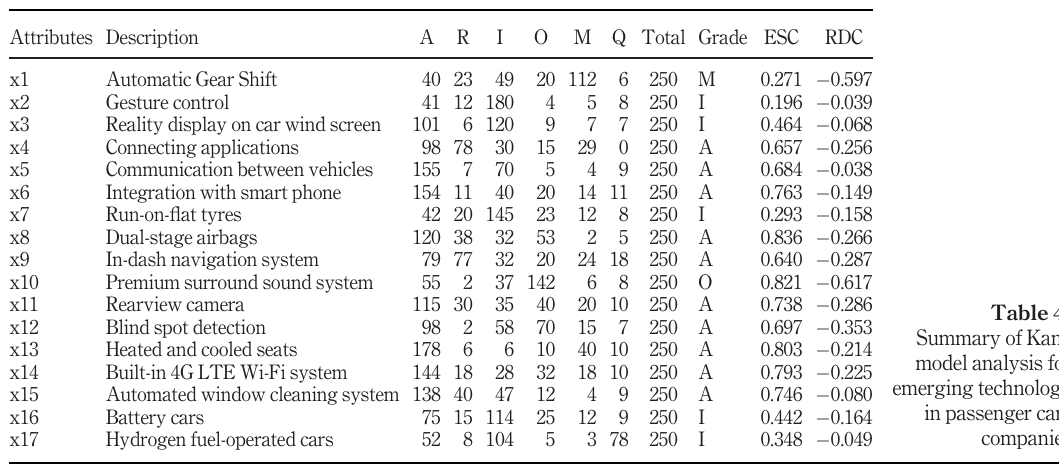
Figure 2. Customer satisfaction